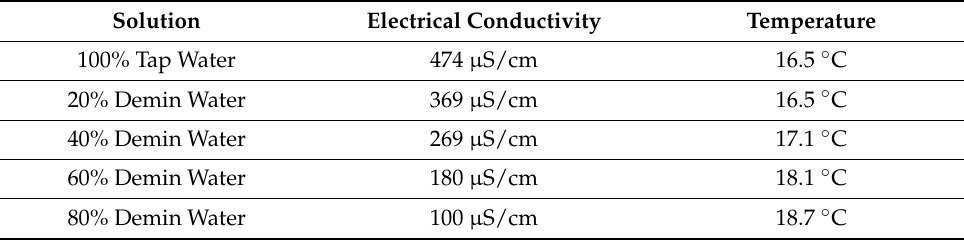
Table 1. Properties of the solutions tested during the calibration experiments.